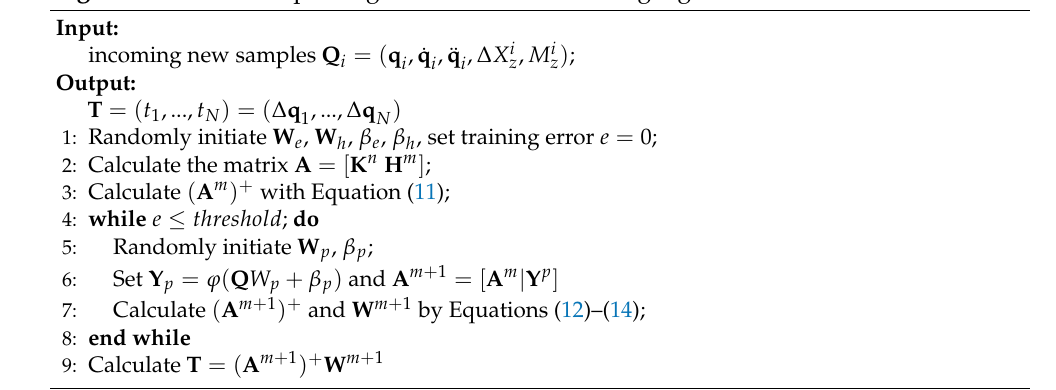
Algorithm 1 Online Updating with increment learning algorithm